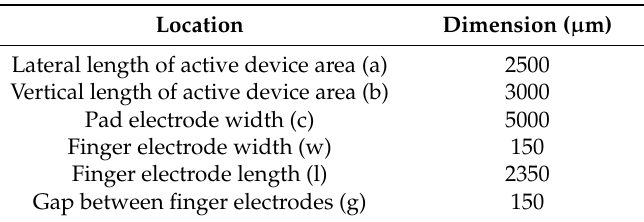
Figure 1. Schematic of the electrode pattern used for imprinting. Table 1. Dimensions of the electrode pattern.